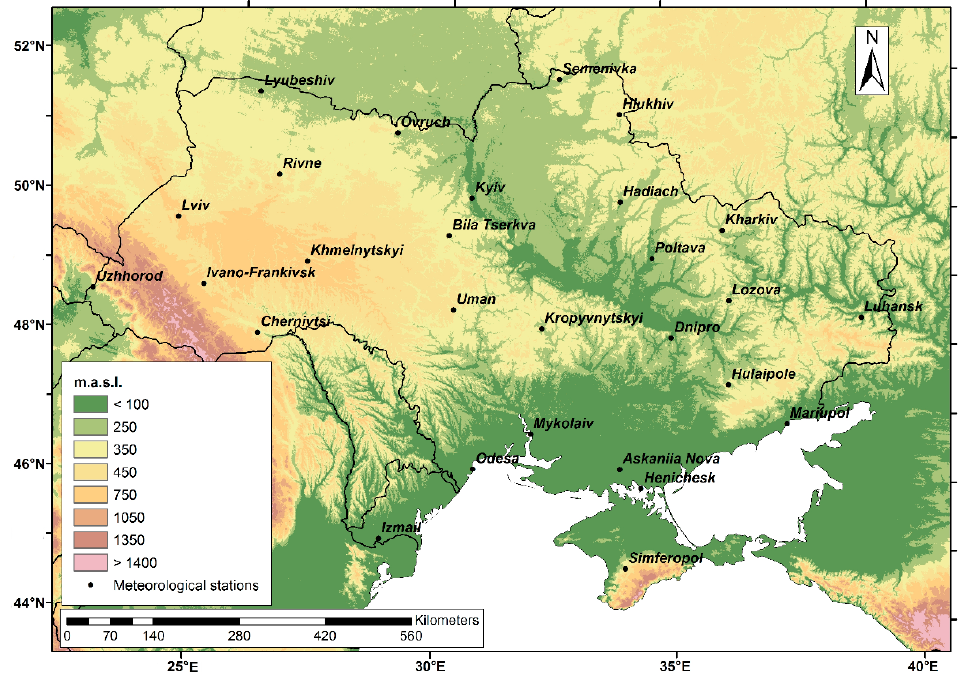
Figure 1. Location of the meteorological stations in Ukraine used in this investigation.